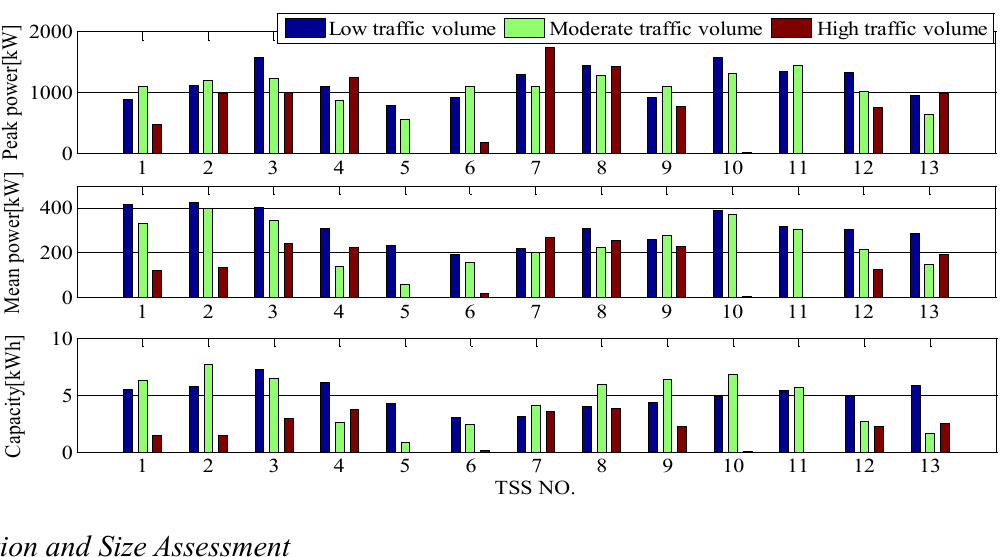
Figure 13. ESS power and capacity of every TSS.